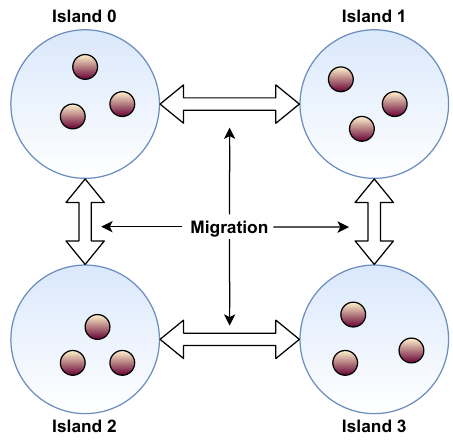
Figure 2. Islands model for genetic algorithms. The light-blue circles represent nodes (islands) and the small brown circles represent individuals. In this architecture, individuals can migrate from an island to another in any direction—the islands do not need to be neighbors.